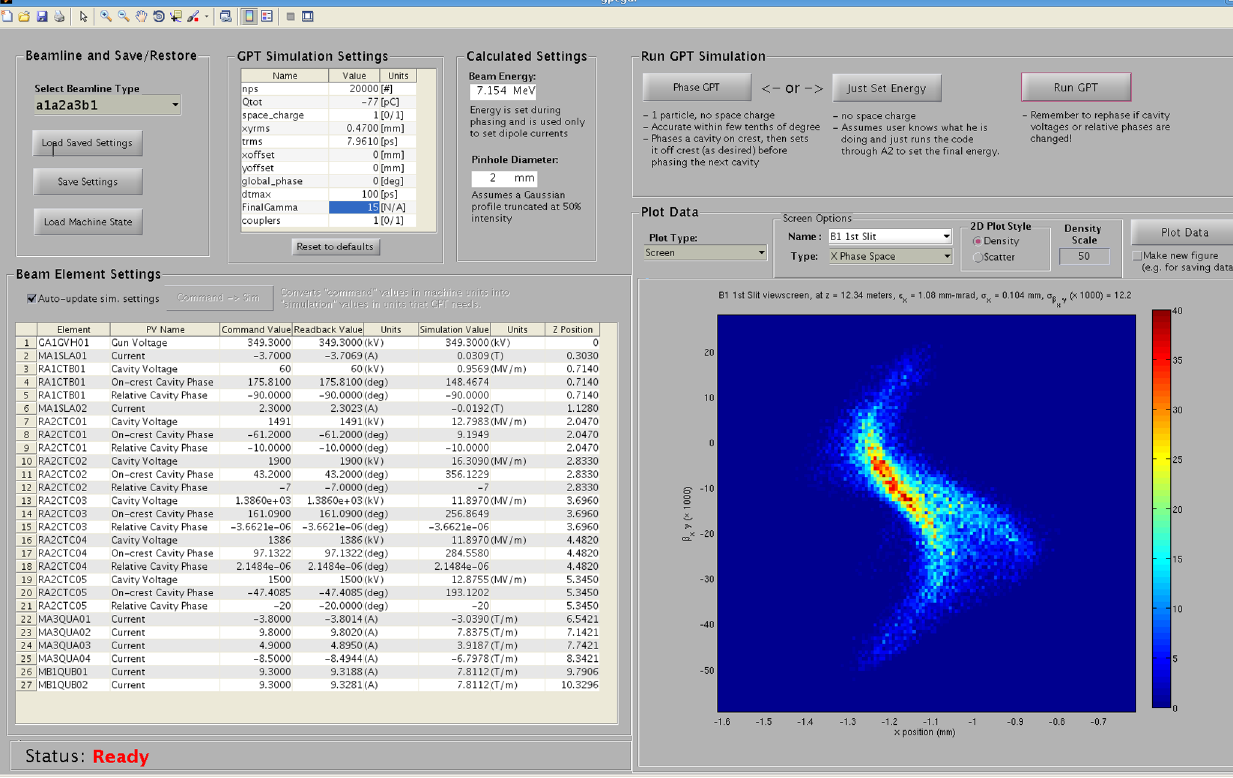
FIG. 5. Screenshot of the virtual accelerator